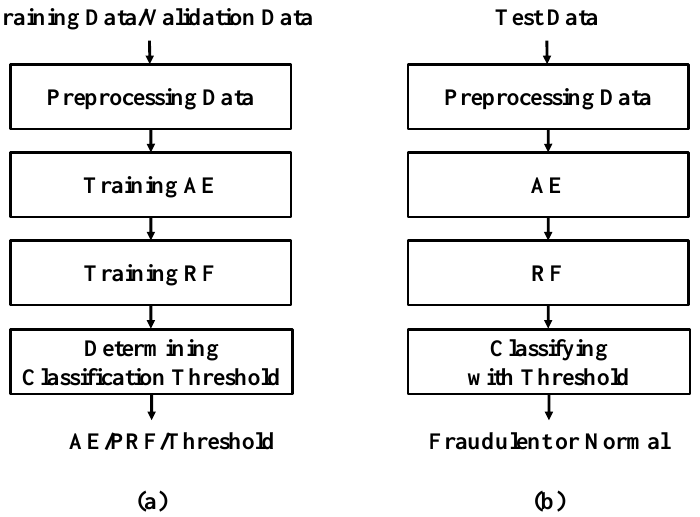
Figure 3. The illustration of AE-PRF: ( a ) the training process, and ( b ) the verification process. Instead of directly using the RF model with a sole classification result, the AE-PRF method uses the RF model with probabilistic classifications to classify data. Specifically, the RF model with probabilistic classifications is used to classify a datum as fraudulent with probability p , and as normal with probability 1 − p , where 0 ≤ p ≤ 1. Afterward, AE-